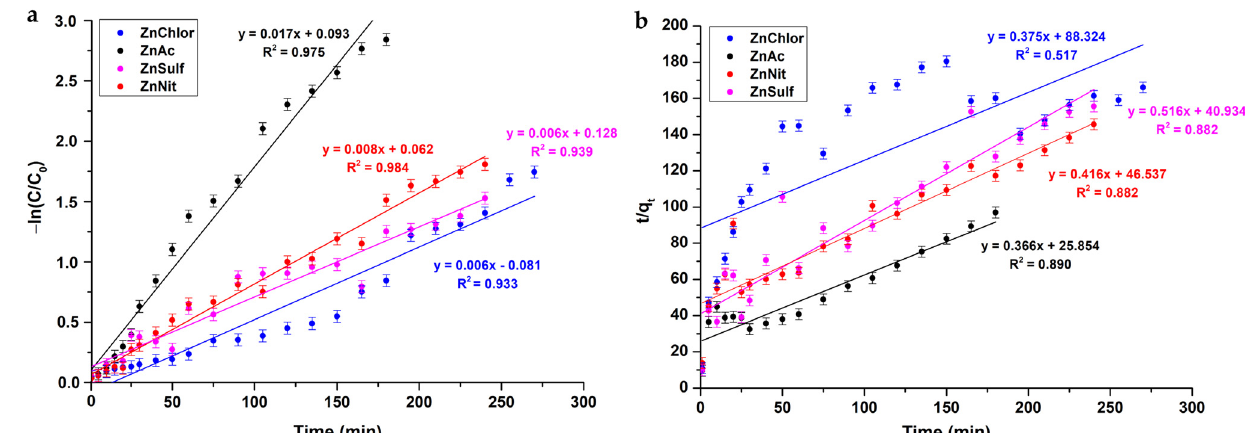
Figure 13. Photocatalytic kinetic model studies for the four different ZnO powders, produced by different precursors, following ( a ) a pseudo-first order model and ( b ) a pseudo-second order model, upon visible light photocatalysis. Table 8. Kinetic parameters of the ZnO powders under visible light photocatalysis.